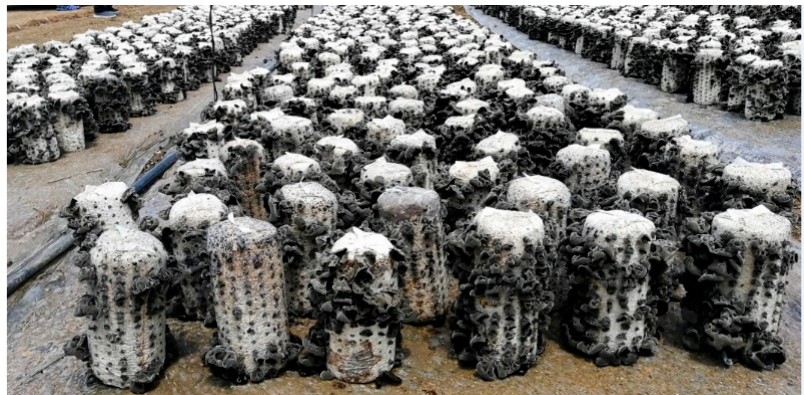
Figure 3. Harvest of Auricularia auricula sticks.